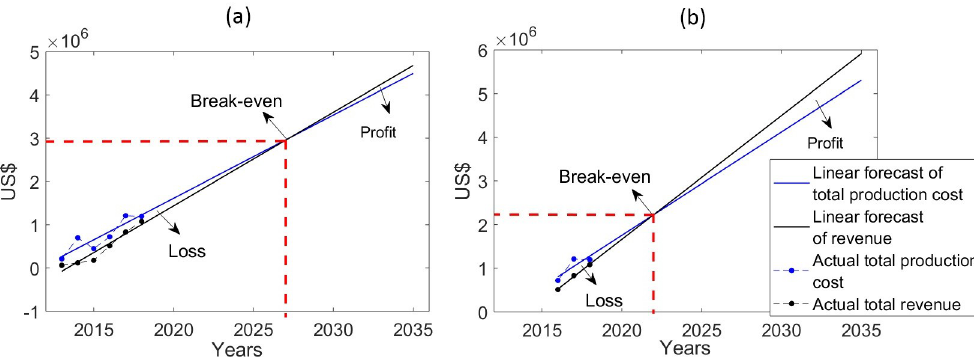
Fig 1. Forecasts of the break-even years of the salt enterprise. Results are shown from using a simple linear model to project forward the total project costs and revenues (in US$). (a) Forecast of break-even year using total cost and total revenue data calculated for 2013–2018 given in Table 2. (b) Forecast of break-even year using total cost and total revenue data calculated for 2016–2018 given in Table 2. The red dotted line indicates the break-even point for each scenario.